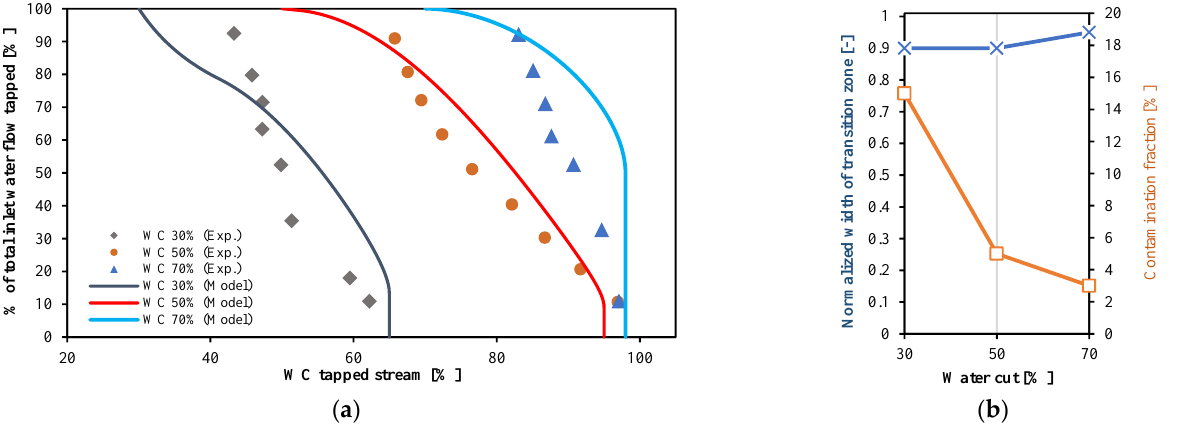
Figure 20. ( a ) Comparison between model prediction and experimental data for spiked oil with total flow rate 700 L/min and WC inlet s 30, 50, and 70%, ( b ) changes of normalized width of transition zone (blue line) and contamination fraction (orange line) vs. WC inlet s.